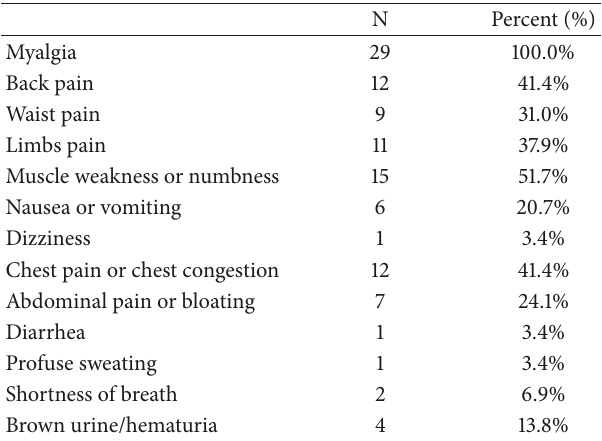
Table 2: Symptoms of all total of 29 rhabdomyolysis cases (N,